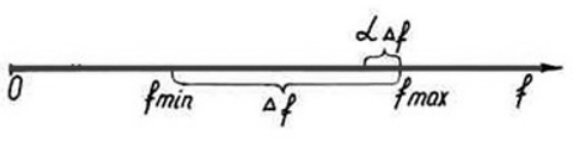
Fig. 2. The approximate location of a single rhythm between the rhythms of the original pacemakers.